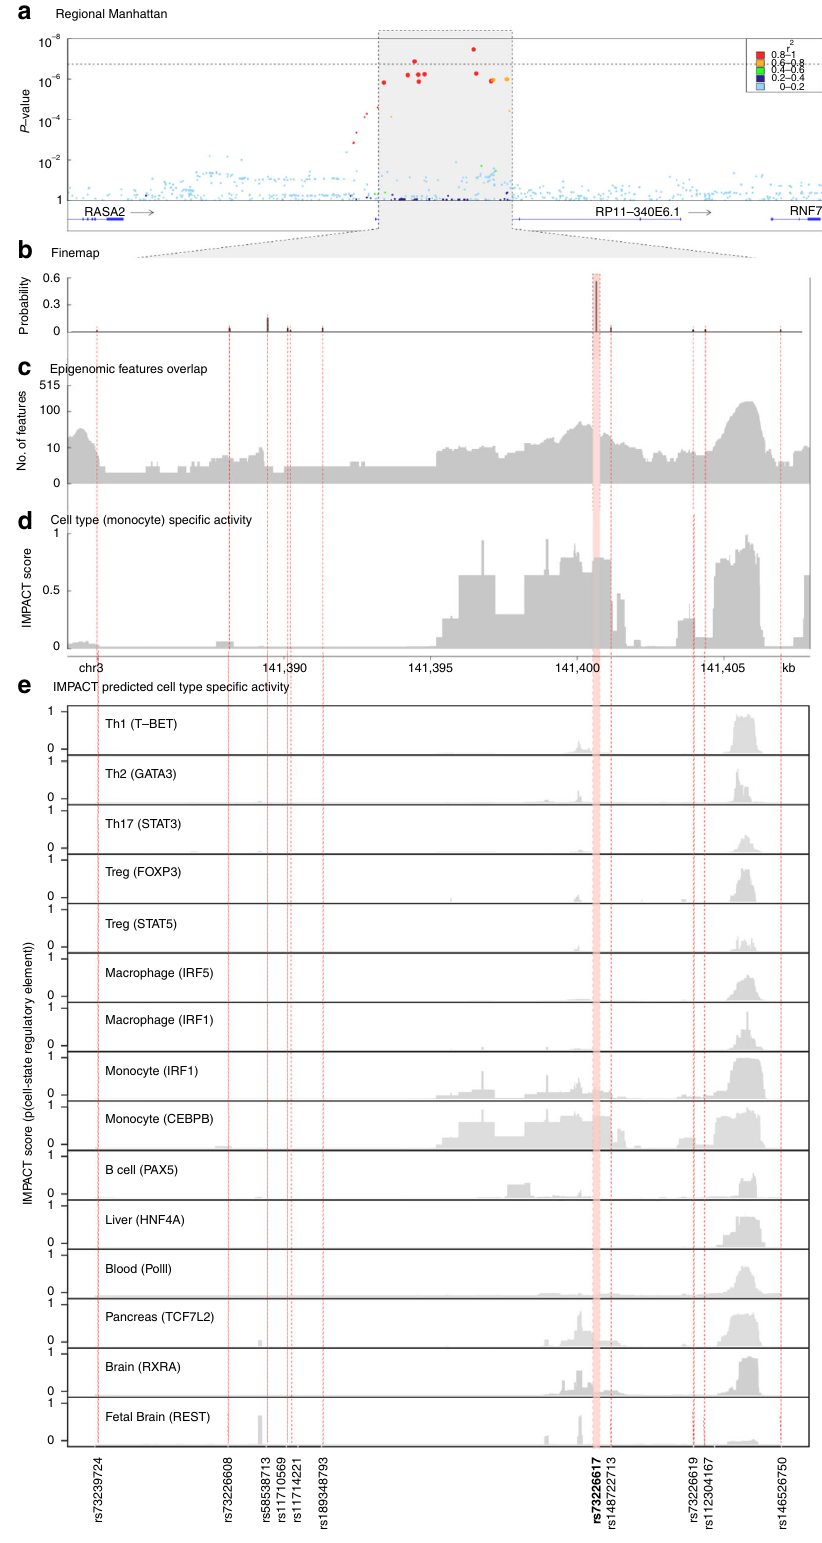
identi fi ed TB risk locus. ATP1B3 (ATPase Na + /K + Transporting Subunit Beta 3) is a protein-coding gene, which belongs to the composed of an alpha, beta, and FXYD subunits, are integral